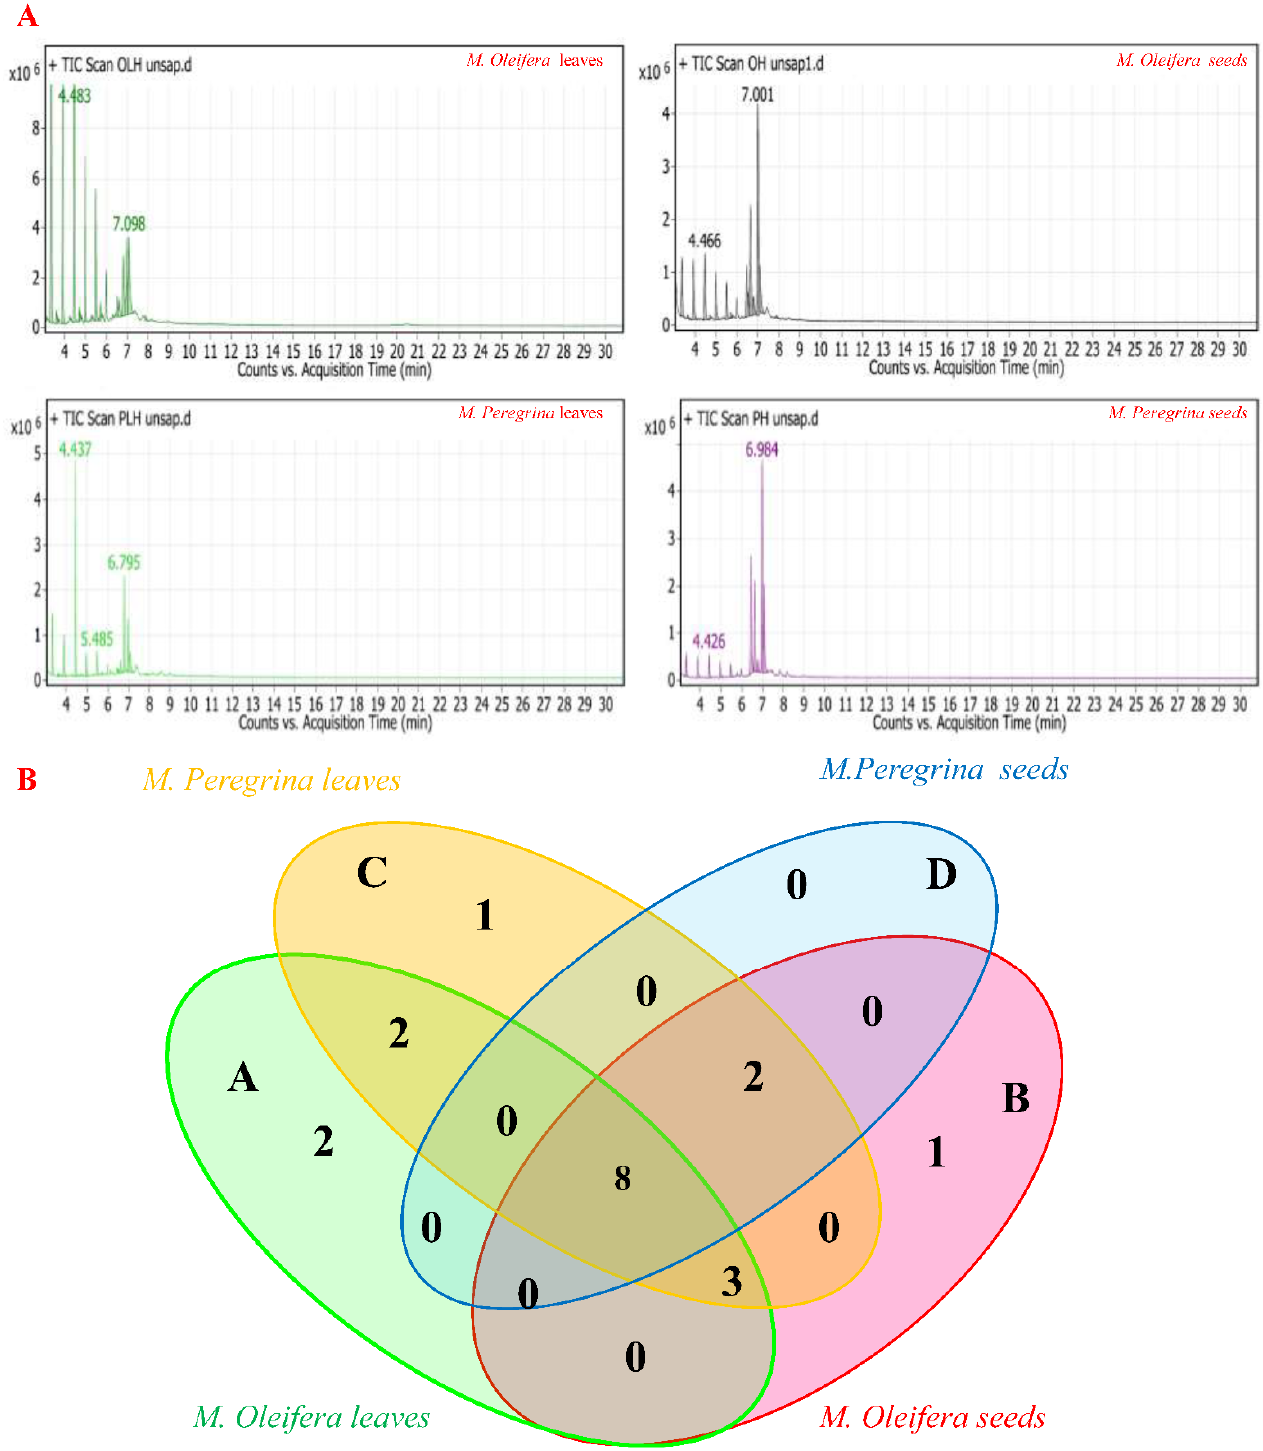
Figure 3. Typical GC-TIC chromatogram for un-saponified from the leaves and seeds of M. oleifera and M. peregrina . ( A ) GC-TIC Peak of the extracts, ( B ) Four-way Venn diagram to show the number of unique and common compounds in the extracts from M.oleifera leaves (a), M. oleifera seeds (b), M. peregrina leaves (c), and M. peregrina seeds (d).